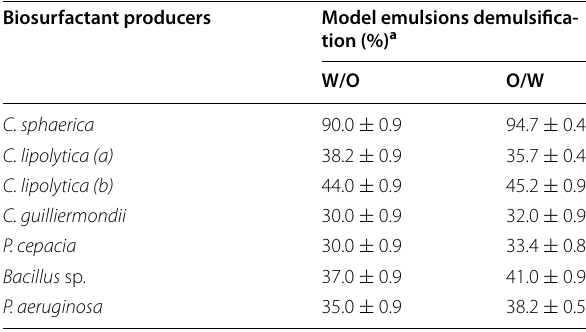
Table 4 Demulsification performance on W/O (Tween–ker- osene) and O/W (Span–Tween–kerosene) model emulsions by the crude biosurfactants (cell-free